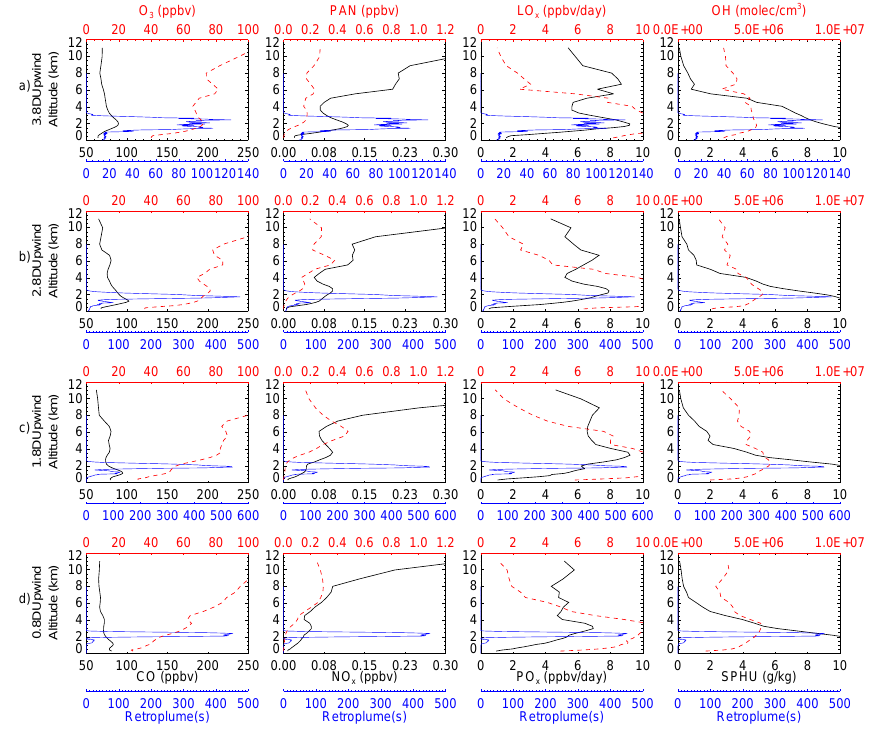
Fig. 8. Same format as in Fig. 7 but for event 6 in